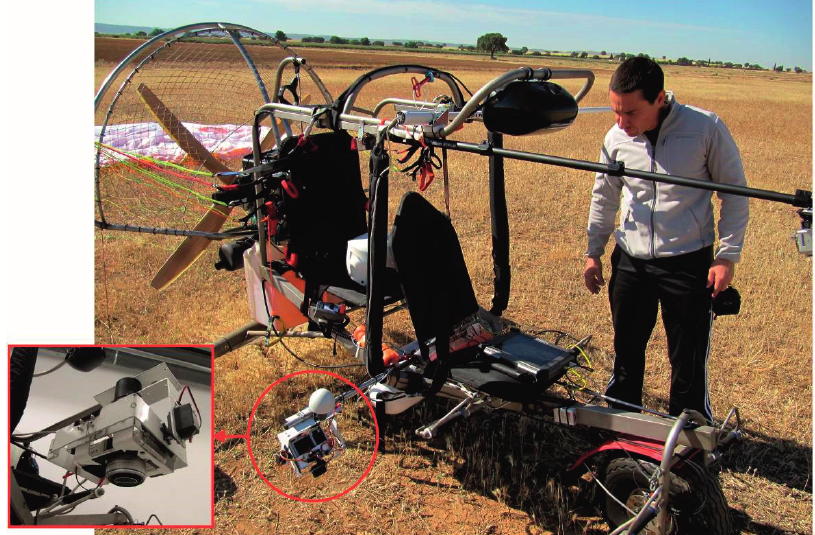
Figure 3. Camera mounting platform and details of the aircraft and the navigation